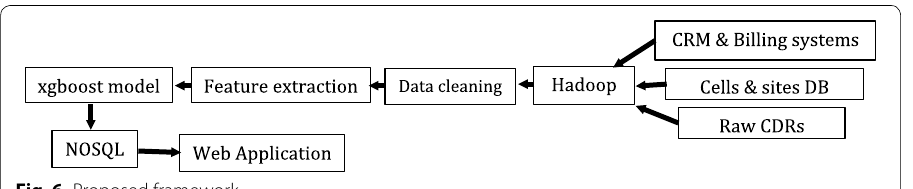
Fig. 6 Proposed framework